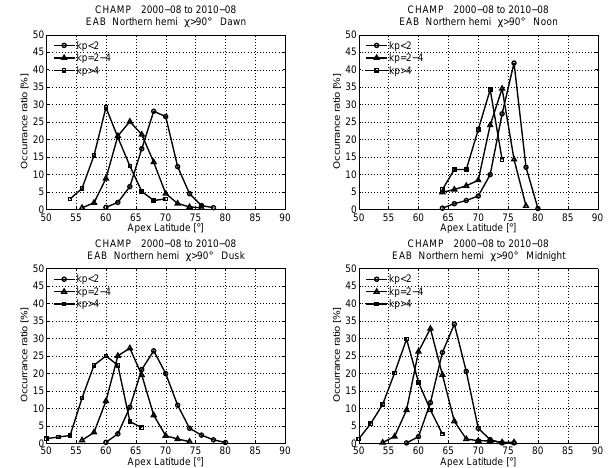
Figure 6. Same as Fig. 5, but for the poleward auroral Fig. 6. Same as Fig. 5, but for the poleward auroral boundary.